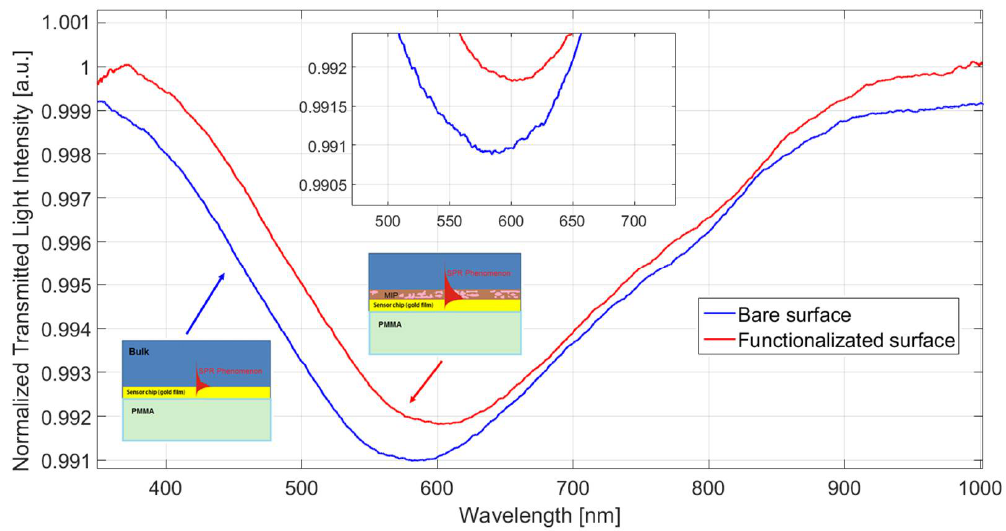
Figure 2. Normalized surface plasmon resonance (SPR) spectra, acquired in a buffer solution as bulk, obtained before and after the functionalization procedure.